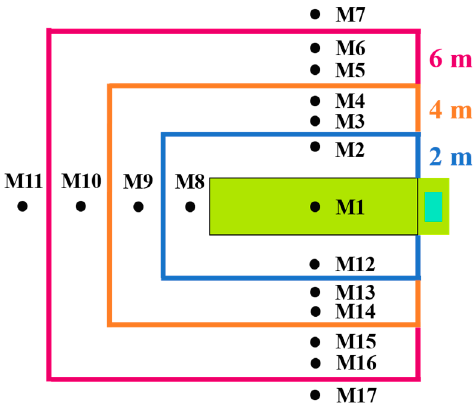
Figure 4. Protective wall models.